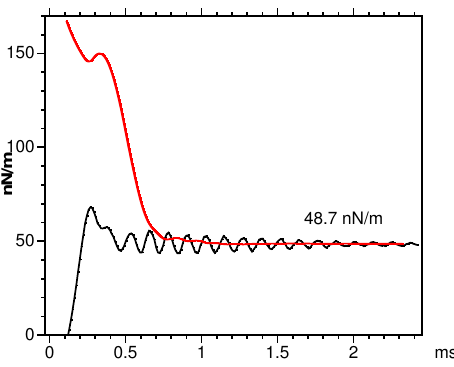
Figure 12. Run Te: same as Fig. 2, but with T e = 0 . 3eV instead of 0.1eV.